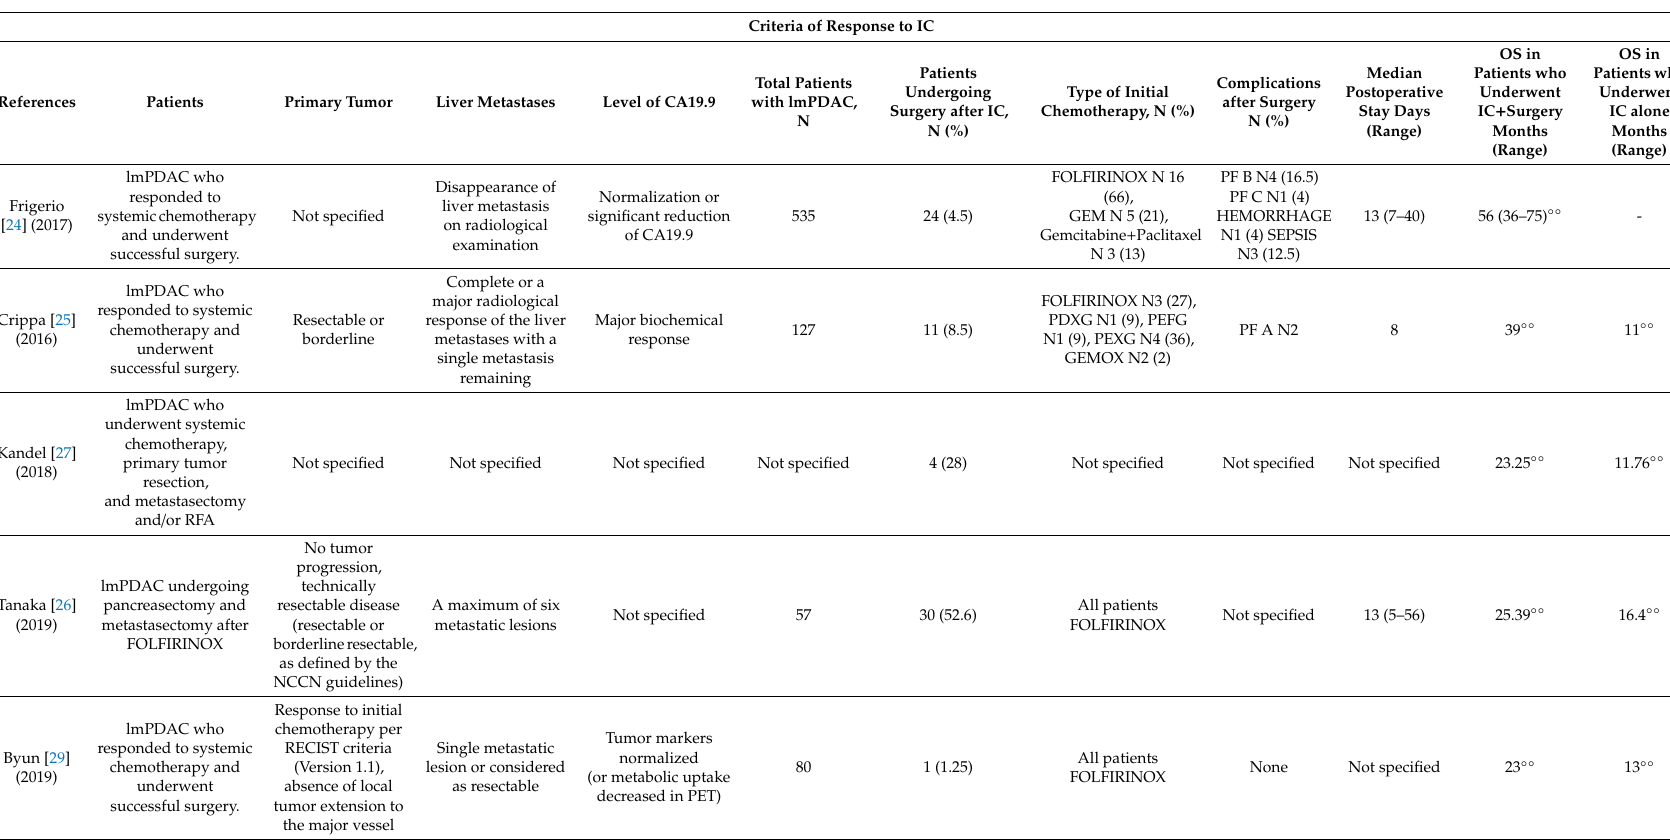
Table 4. Criteria of response to initial chemotherapy, inclusion criteria for surgery, IC regimens and outcomes of five series of patients with lmPDAC who underwent surgery after